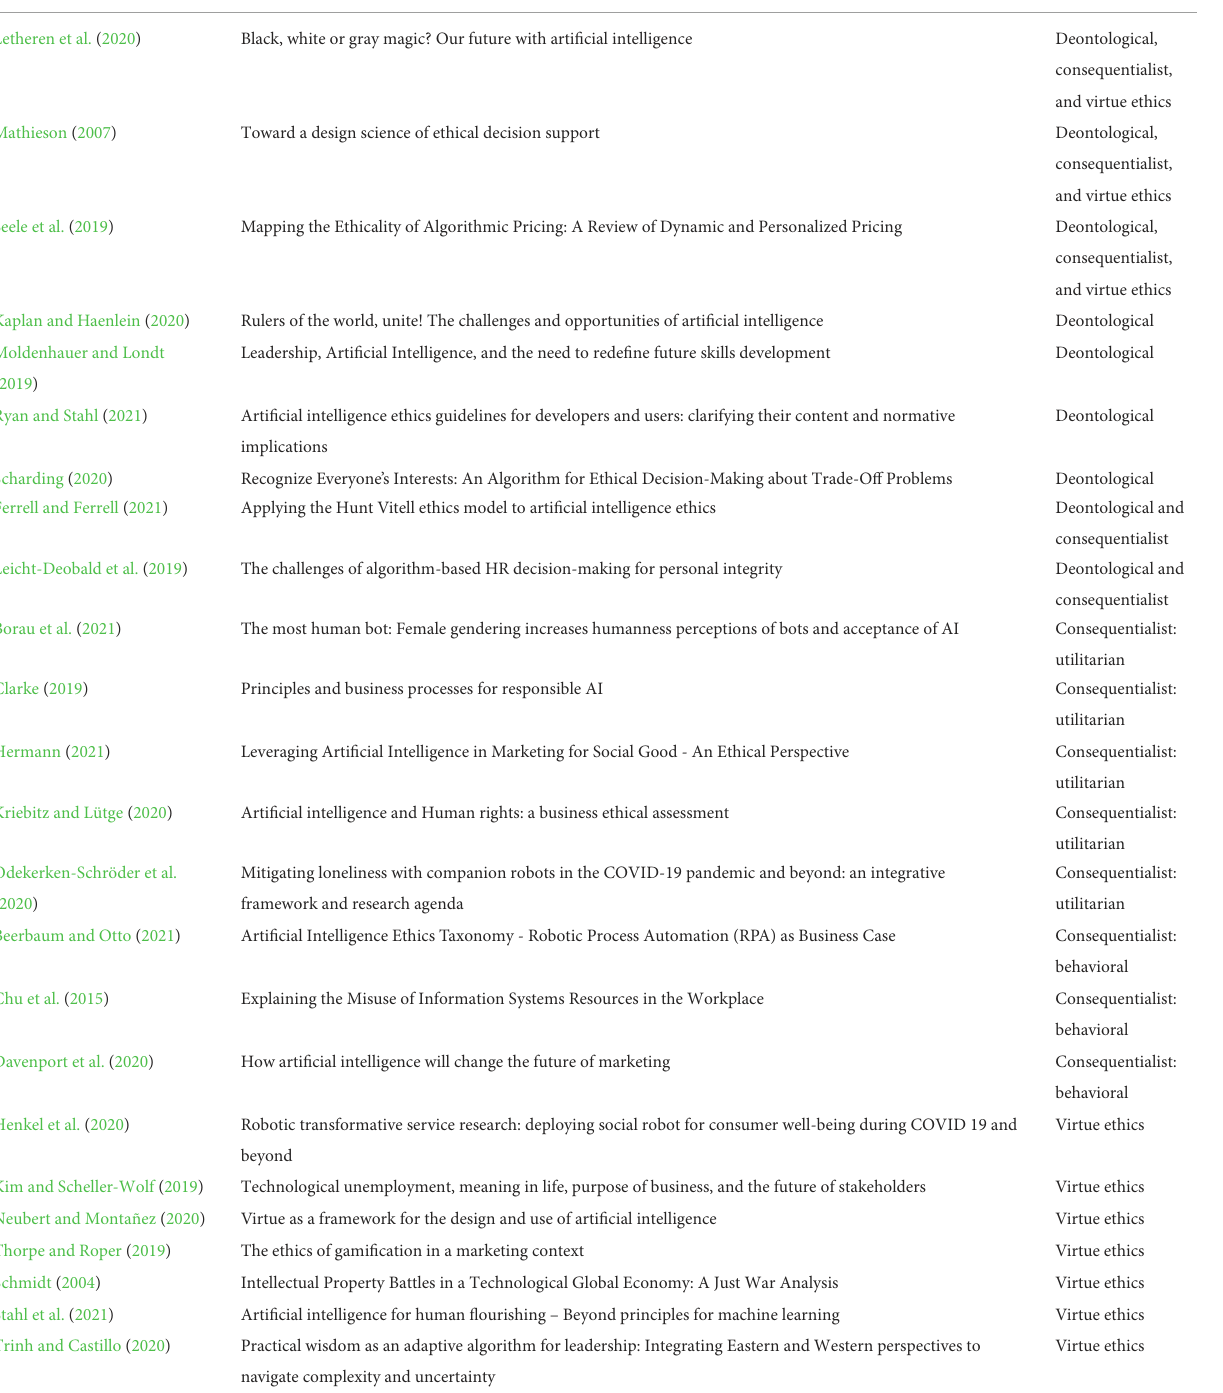
TABLE 8 Articles with an ethical theory